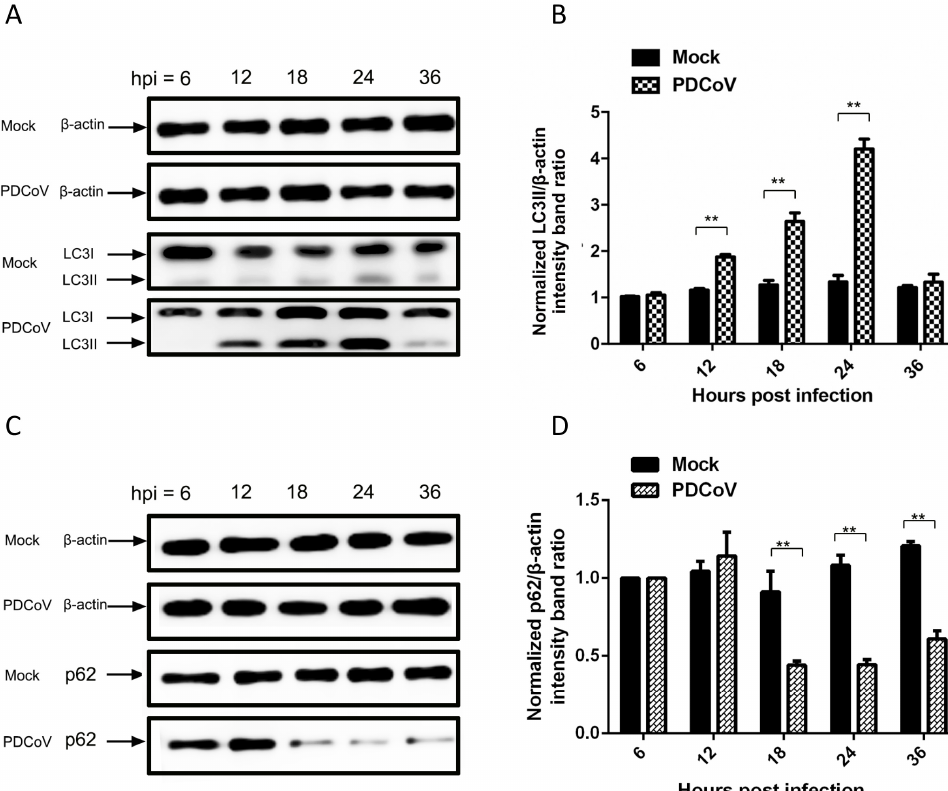
Figure 4. PDCoV infection increased the conversion of LC3-I to LC3-II ( A , B ) as well as degradation of p62 proteins in LLC-PK1 cells ( C , D ). LLC-PK1 cells were mock-treated or infected with PDCoV (multiplicity of infection (MOI) = 1). At 6, 12, 18, 24 and 36 hpi, cells were lysed and subjected to western blot with antibodies against LC3, p62 and β -actin (as the loading control). The protein blots were quantified by the Image J software. The ratio of LC3-II to β -actin and the ratio of p62 to β -actin from three independent experiments were expressed as mean ± standard deviation (SD); ** p < 0.01, calculated using Student’s t -test.